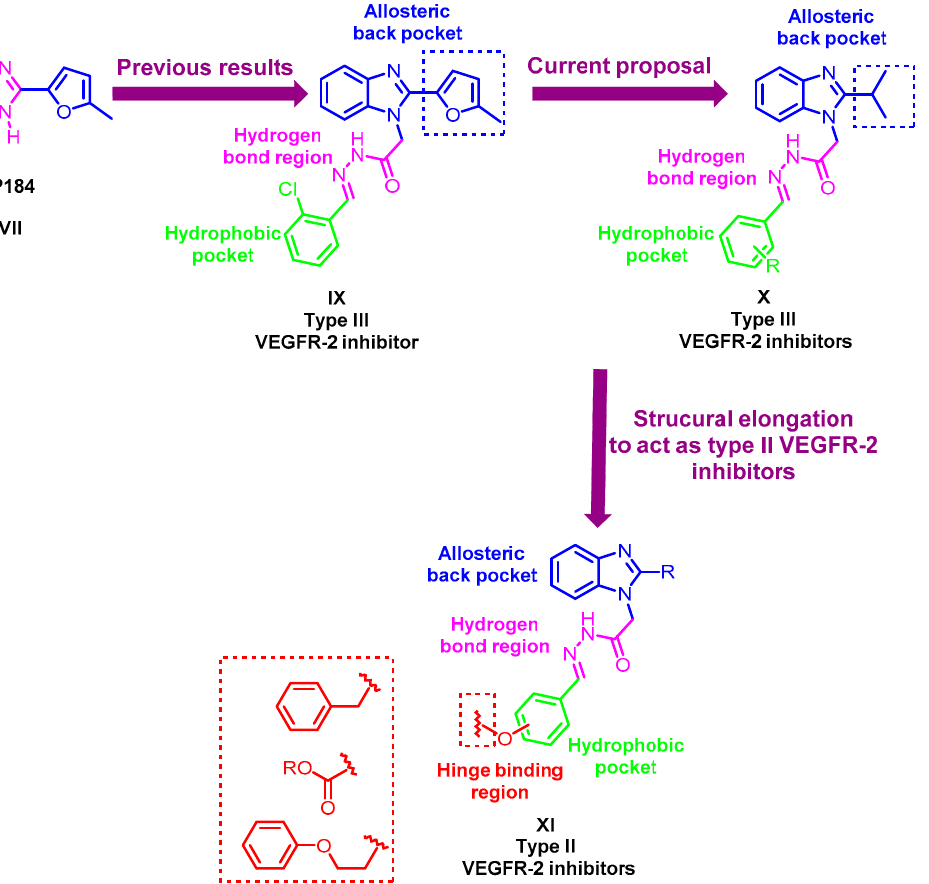
Figure 4. Schematic representation for the design strategy of the novel 1,2-disubstituted-benzimidazole derivatives X and XI .